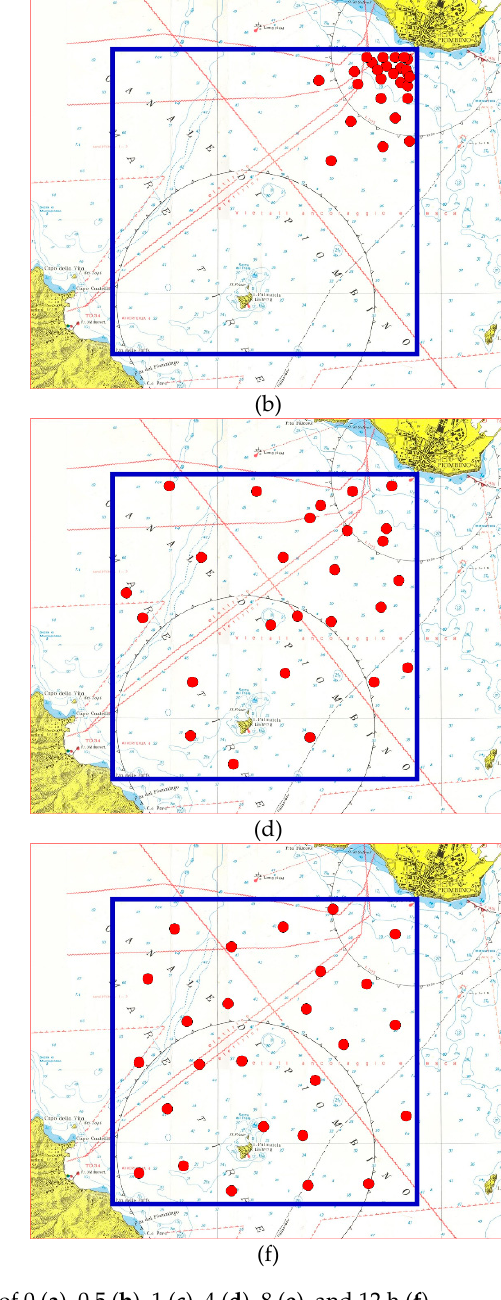
Figure 8. “Snapshots” over time, at intervals of 0 ( a ), 0.5 ( b ), 1 ( c ), 4 ( d ), 8 ( e ), and 12 h ( f ).